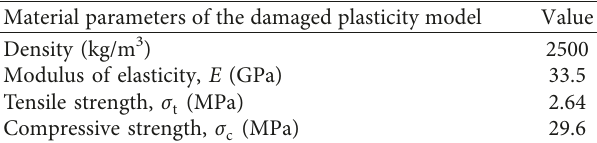
Table 4: Material parameters of the damaged plasticity model for concrete.